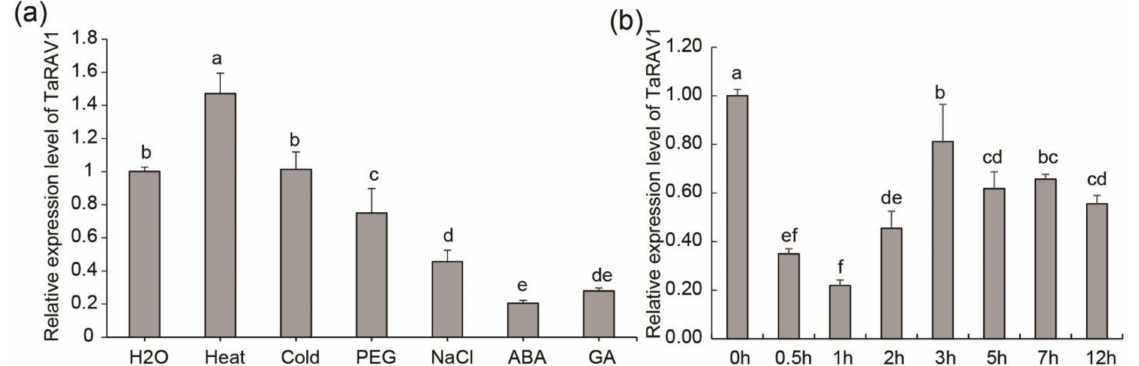
Figure 3. qRT-PCR analysis of TaRAV1 expression in wheat seedlings treated with stresses or hor- mones. ( a ), Expression levels of TaRAV1 in response to different treatments. Seeds were germinated under normal conditions, and before RNA extraction, 2-week-old seedlings were treated for 2 h with heat (42 ◦ C), cold (4 ◦ C), PEG (20% PEG6000), NaCl (200 mM), ABA (100 µ M), or GA (100 µ M). ( b ), Expression levels of TaRAV1 in response to different lengths of NaCl treatment. Seedlings were prepared the same way as in ( a ), and treated with 200 mM NaCl for different lengths of time. Tran- script levels were quantified using the qRT-PCR method, and normalized to that of Taactin . Data shown are means ± SE (n = 3). Different letters represent significant differences ( p < 0.05, one-way